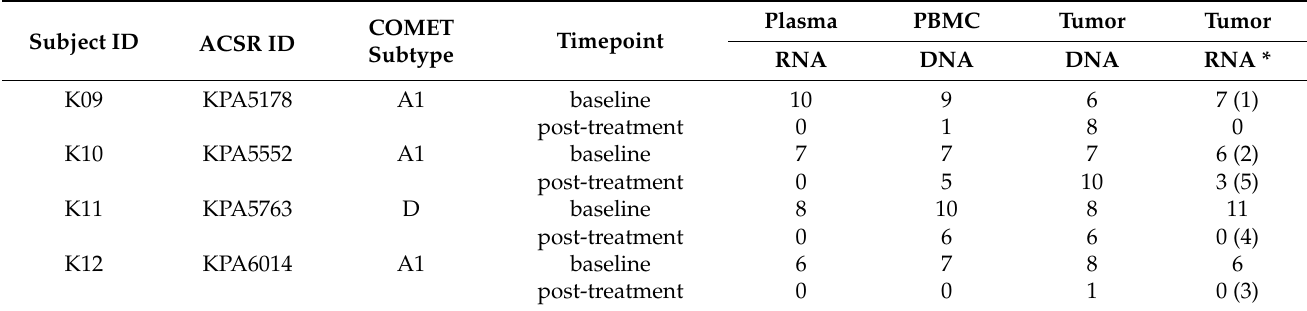
Table 3. HIV subtype and number of sequences, excluding truncated, incomplete, or hypermu- tated sequences.